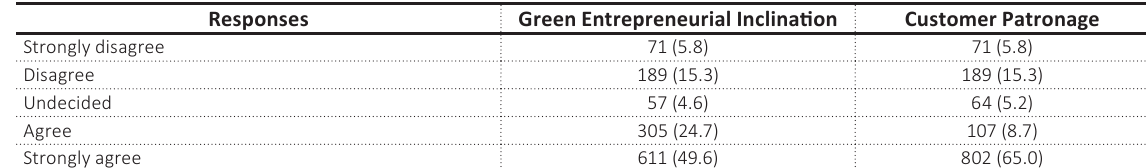
Source: Authors’ elaboration.